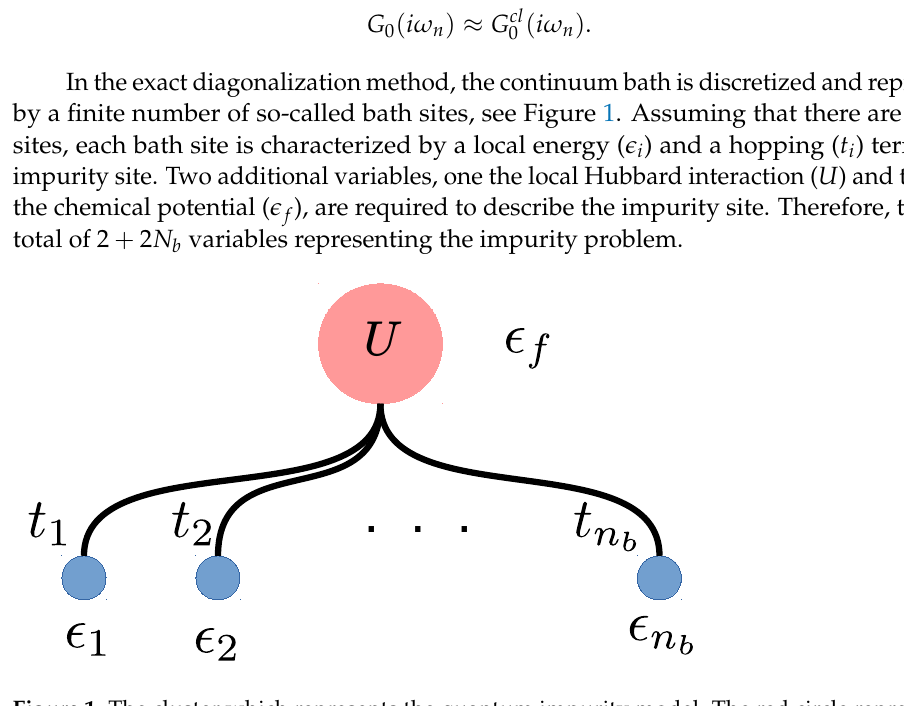
Figure 1. The cluster which represents the quantum impurity model. The red circle represents the impurity site with local interaction U and chemical potential (cid:101) f . The bath sites are represented by blue circles; each of them has a local energy (cid:101) i , and a hopping to the impurity site t i